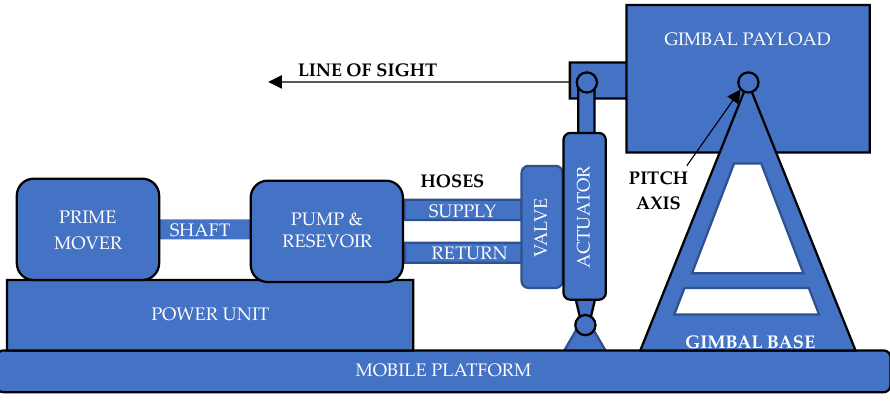
Figure 1. Stabilized system on mobile platform.